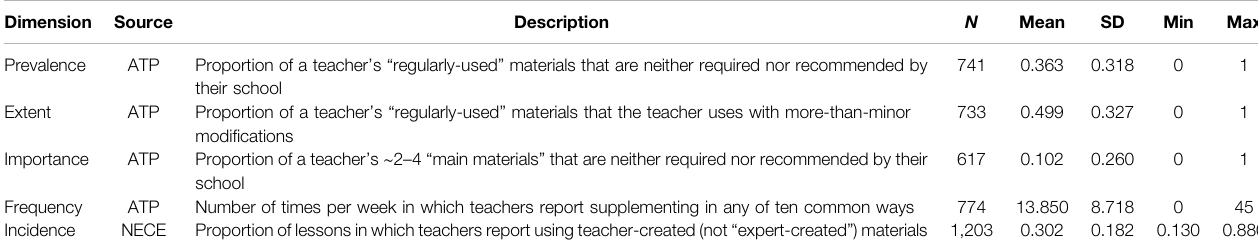
TABLE 1 | Supplement use pattern descriptions and summary statistics. Dimension